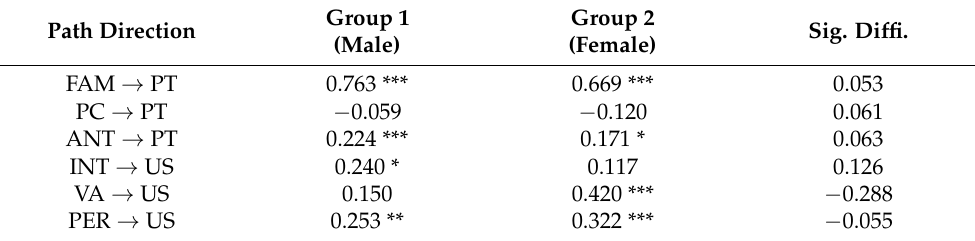
Table 7. The results of multigroup analysis